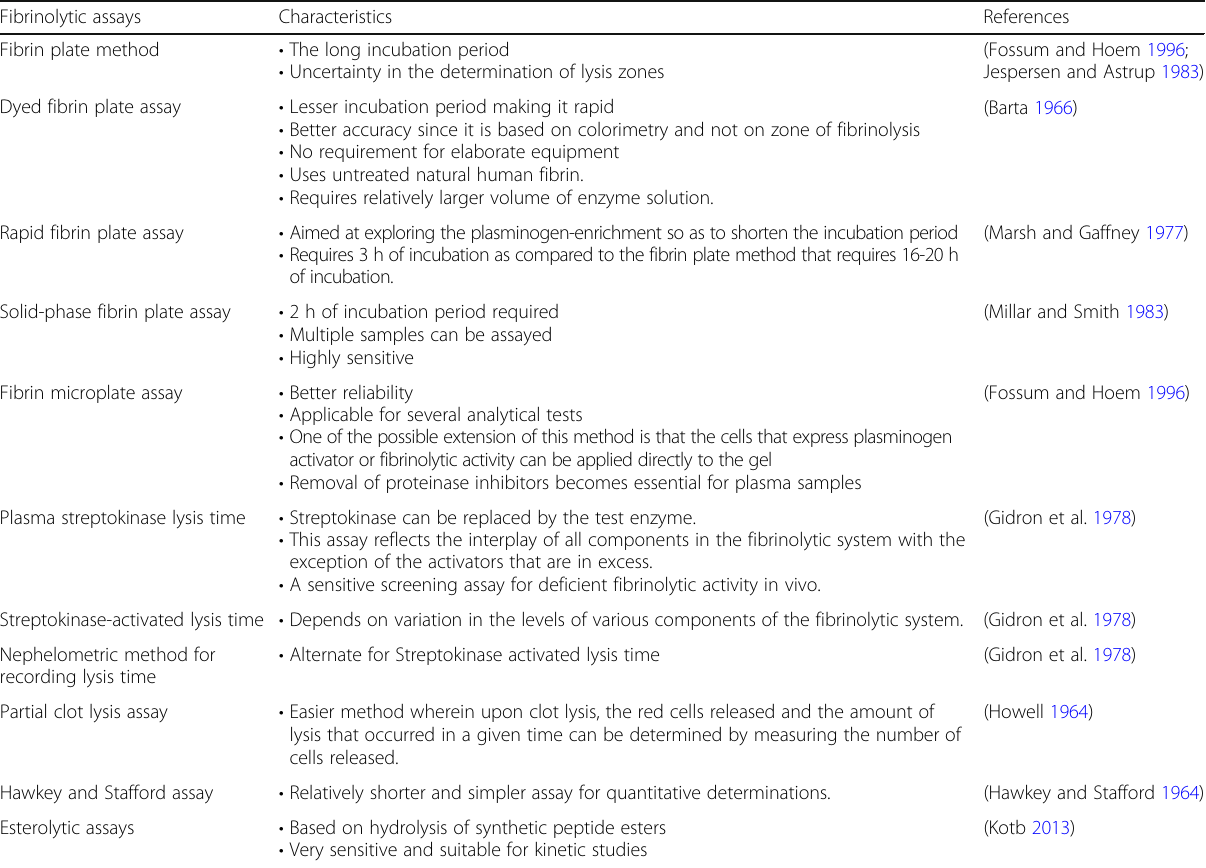
Table 1 List of various fibrinolytic assays Fibrinolytic assays Characteristics